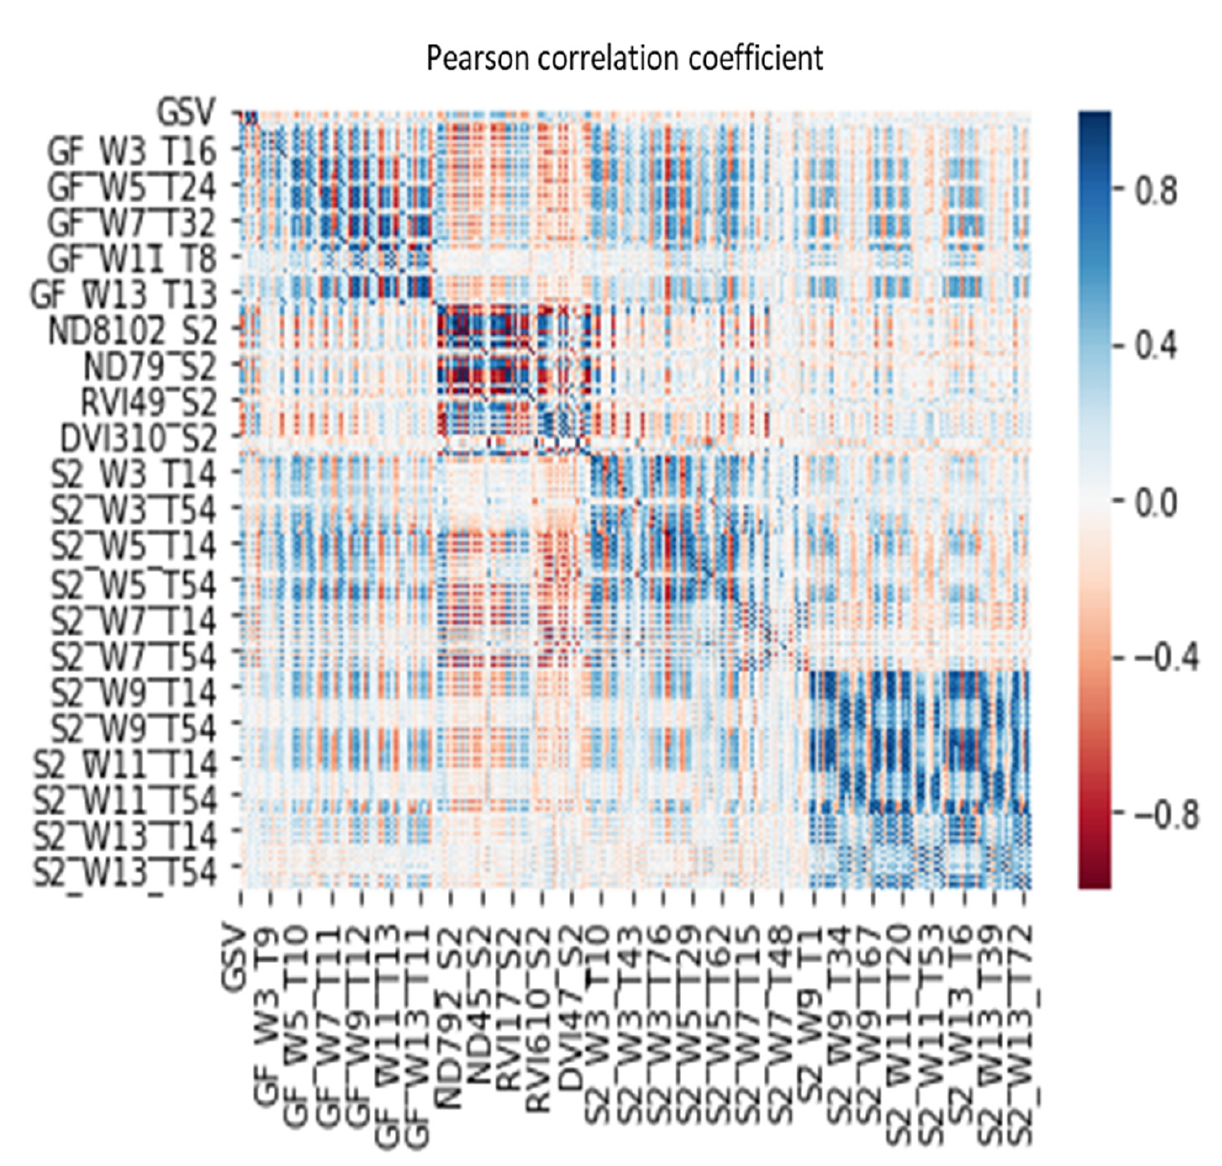
Figure A1. The correlation analysis between the feature variables extracted from the integrated dataset of GF-2 and Sentinel-2 images. GF, GaoFen-2, S2, Sentinel-2, W, the size of the window, T, Serial number of texture feature variables based on band number and texture feature number sequential connection, for example, the eighth texture feature of the second band image can be denated as